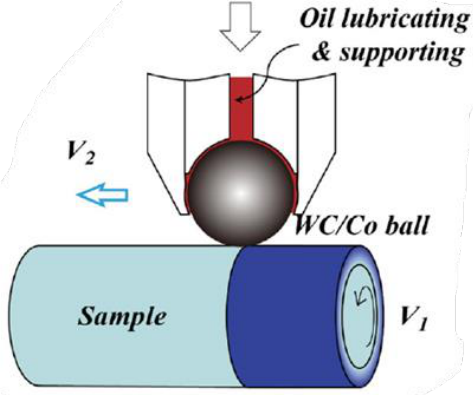
Figure 3. Illustration of SMRT treatment. Reprinted with permission from Ref. [22]. Copyright 2015 Elsevier.